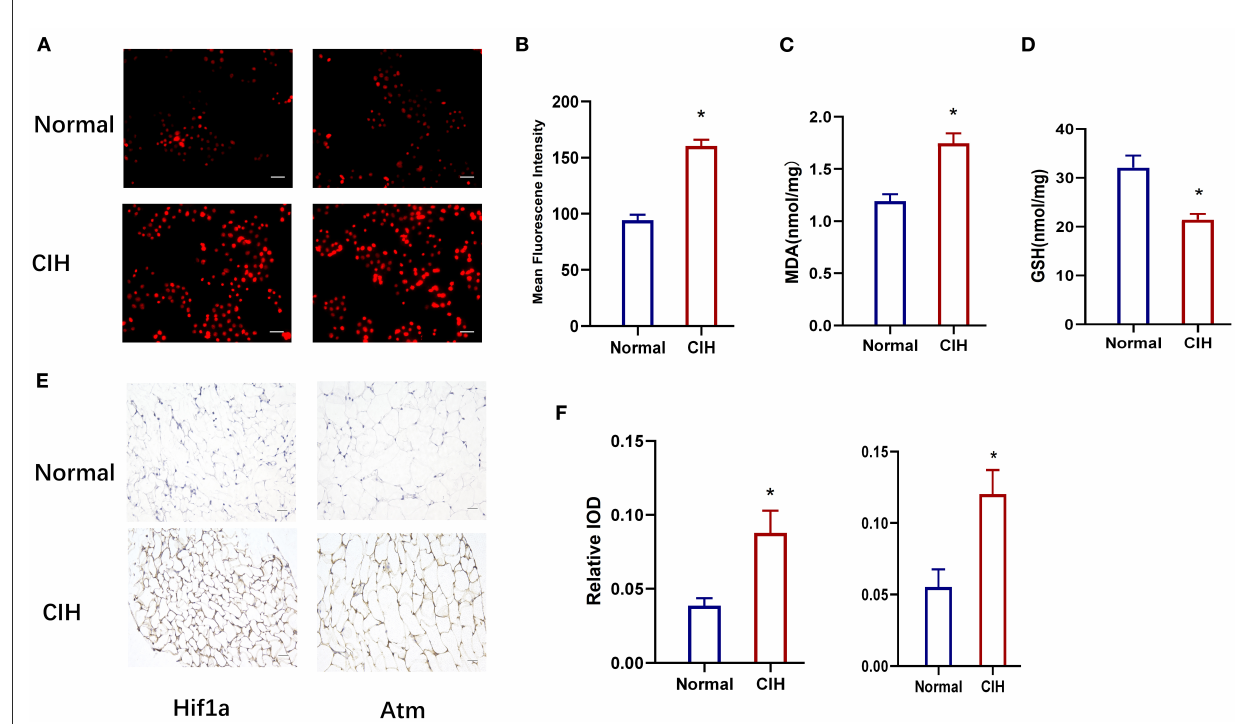
FIGURE7 Establishment of chronic intermittent hypoxia model (CIH) in rats, validated by ROS, MDA, GSH, and IHC. (A, B) The expression of ROS in rat lung tissue in different groups. Original magnification is × 400, Scare bar, 25 µ m. (C, D) The expression of MDA and GSH in different groups. (E, F) HIF1A and ATM protein expression variations in different groups were detected by immunohistochemistry. Magnification × 200, Scare bar, 100 µ m. * P <